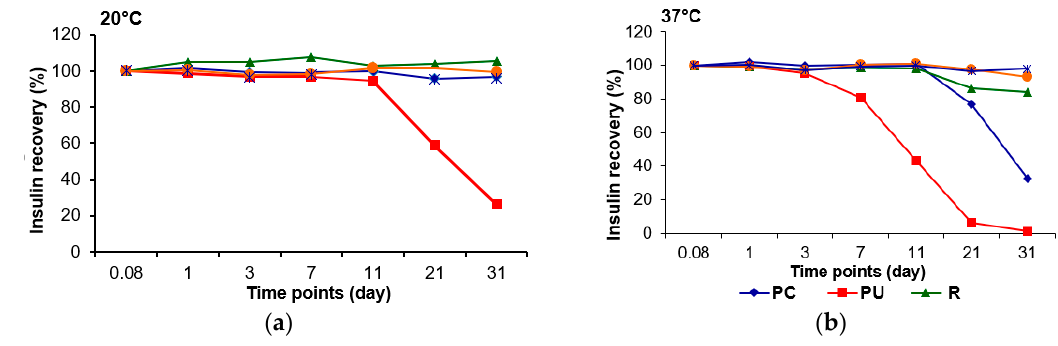
Figure 2. ( a ) Hum R insulin recovery over time for each test material at 20 °C and ( b ) 37 °C for